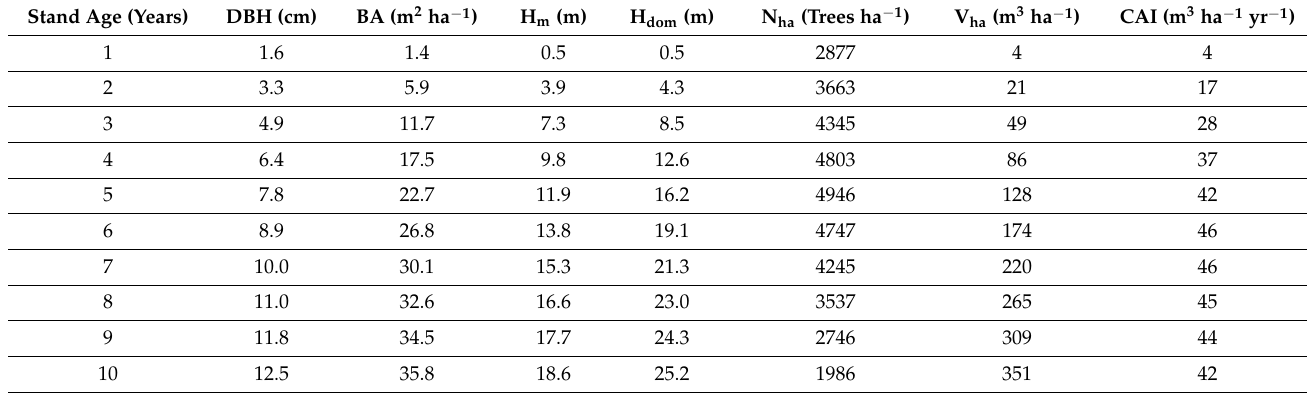
Table 4. Yield table developed in the present study for Acacia hybrid plantations in Vietnam. Diameter at breast height (DBH), basal area (BA), mean height (H m ), dominant height (H dom ), number of trees per hectare (N ha ), volume per hectare (V ha ), and current annual increment (CAI) were calculated against stand age using the growth models developed in this